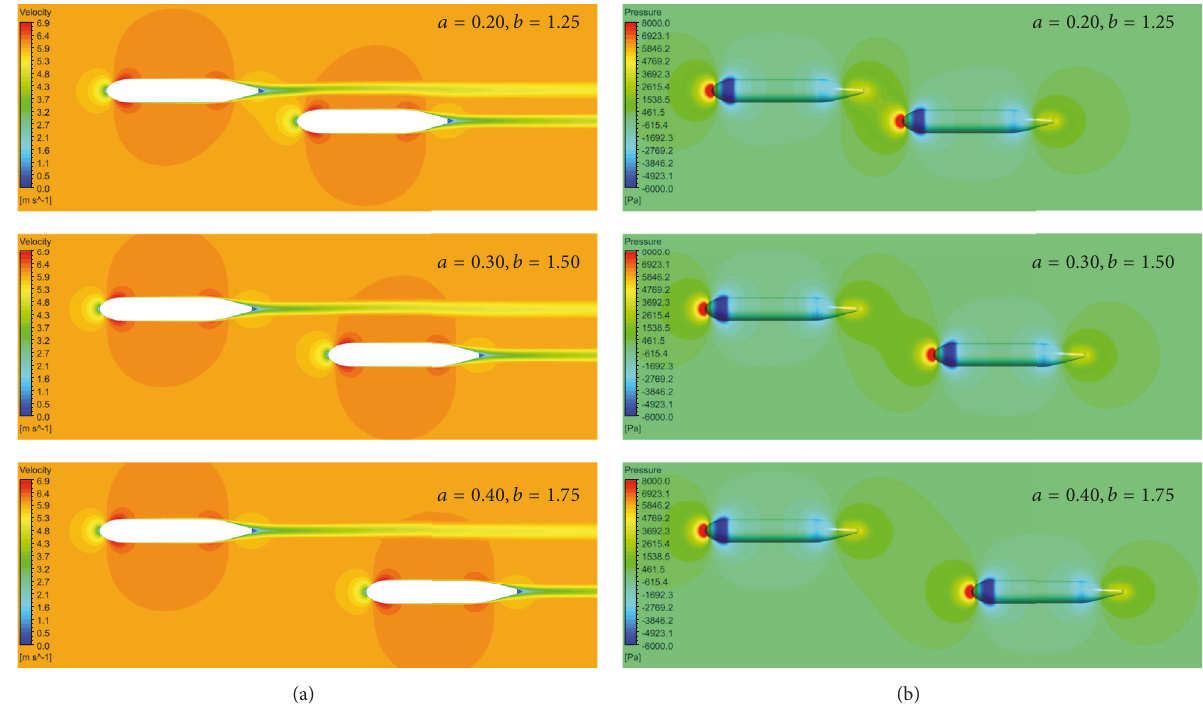
Figure 14: Contours of (a) velocity and (b) pressure around two AUVs in the Pull Region.